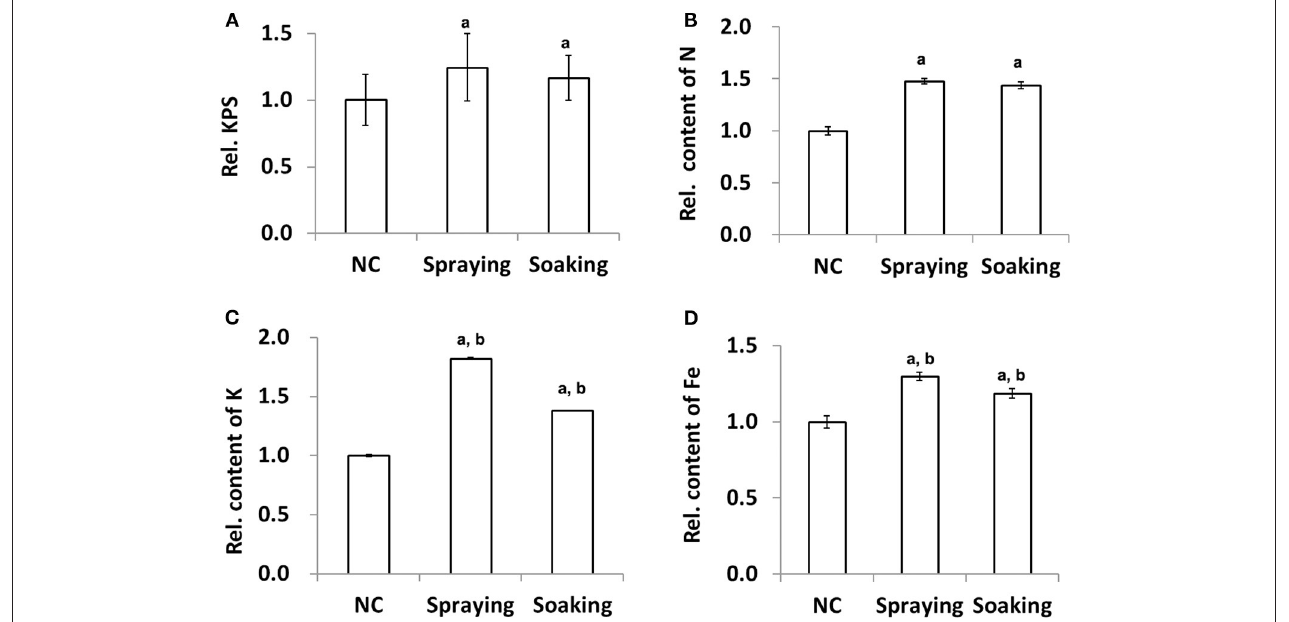
FIGURE 1 | Effect of WR10 inoculation on wheat grain yield production and nutrient content. (A) The relative mean number of kernels per spike (KPS) of 30 wheat plants; (B) Relative content of total N in grains; (C) Relative content of K in grains; (D) Relative content of Fe in grains. Content of macronutrients was calculated as mg/g, and that of micronutrients was calculated as mg/kg dry weight (DW). Original data were analyzed by ANOVA pair-wise comparisons using LDS-test and p < 0.05 was considered significant. All data in the figure were normalized to their counterparts in the control group (NC) without inoculation of bacteria. In spraying, soils were sprayed with B. altitudinis WR10 before sowing of wheat; in soaking, wheat seeds were soaked in B. altitudinis WR10 suspension before sowing. a, statistically different from NC; b, significantly different between spraying and soaking